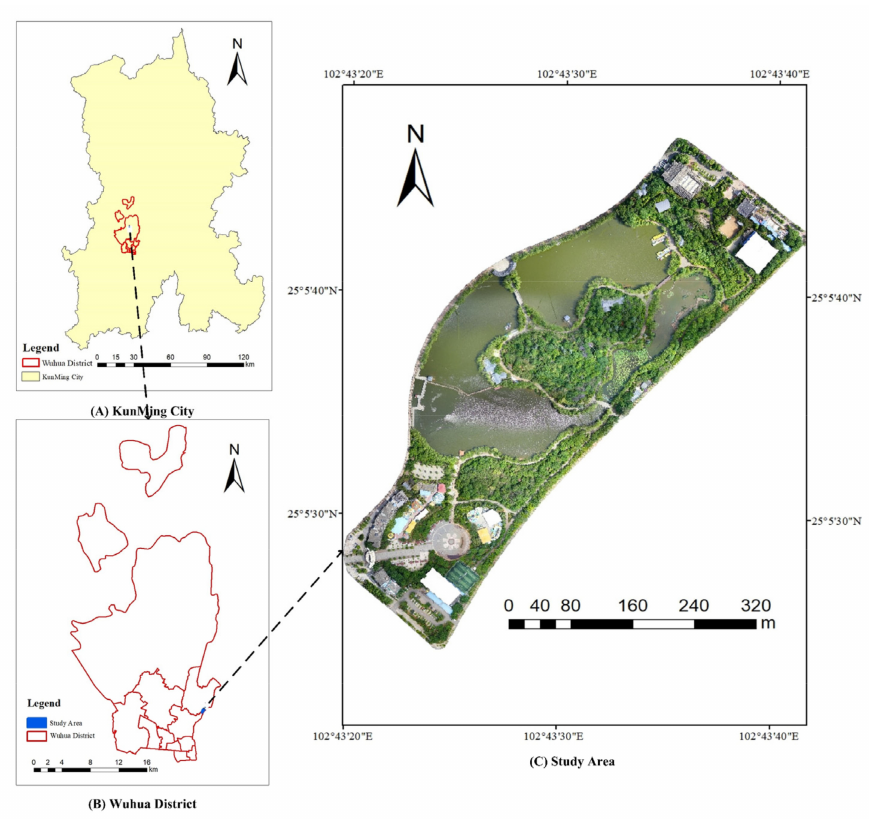
Figure 2. Location of YueYaTan